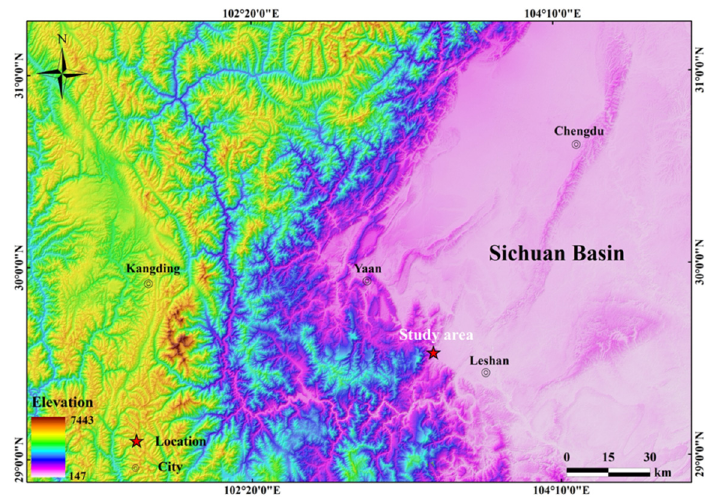
Figure 1. Location of the study area.